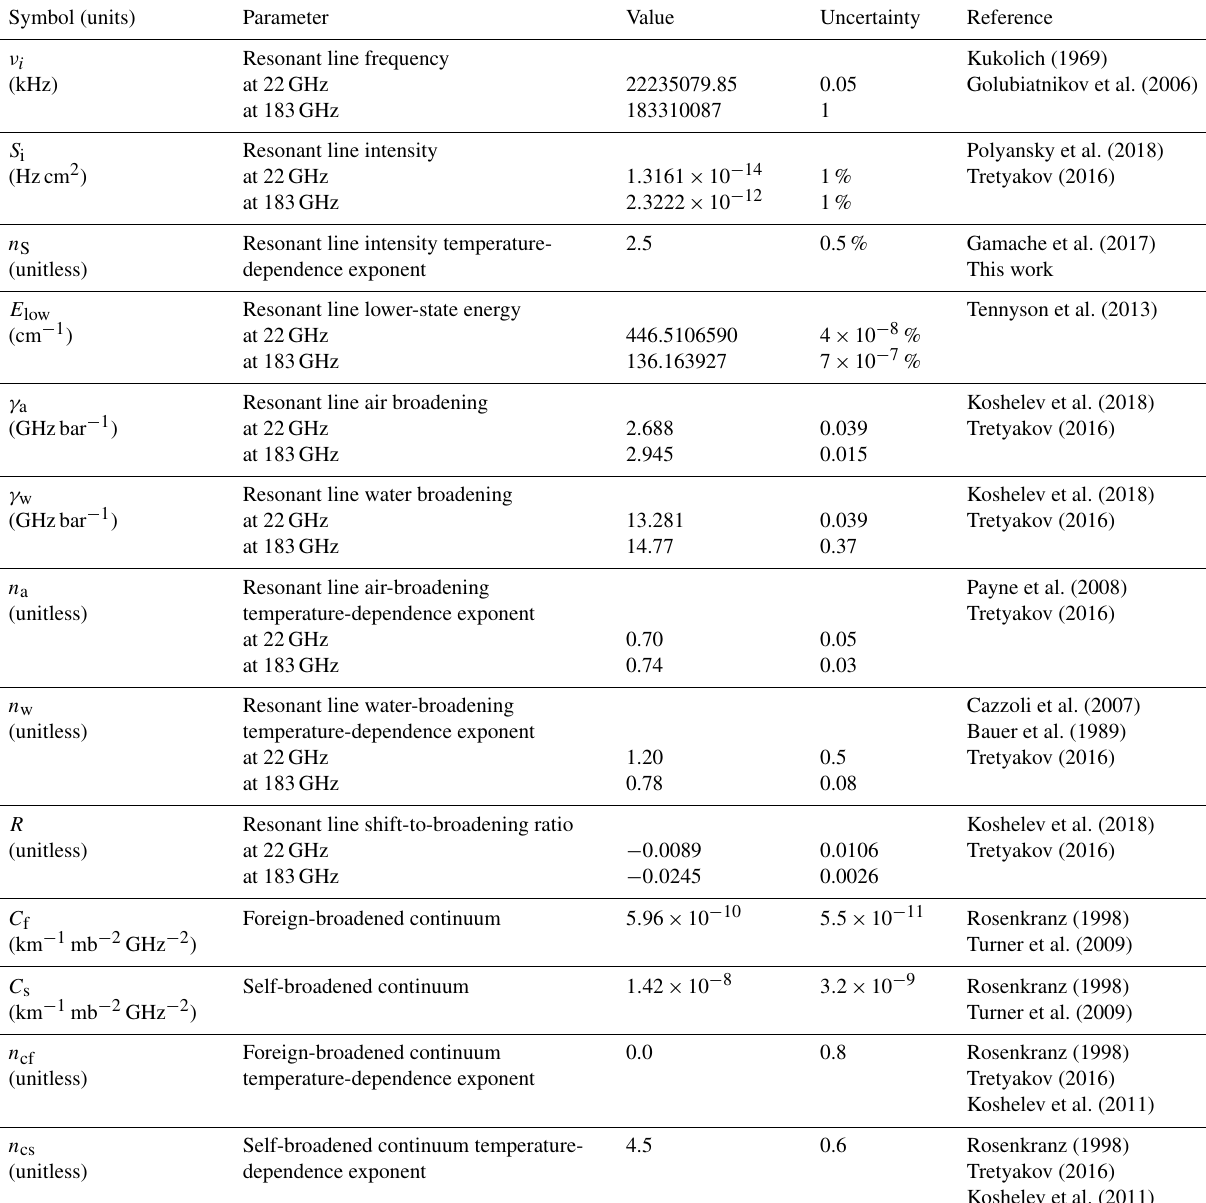
Table 1. List of water vapor parameters perturbed in the sensitivity analysis. Symbol